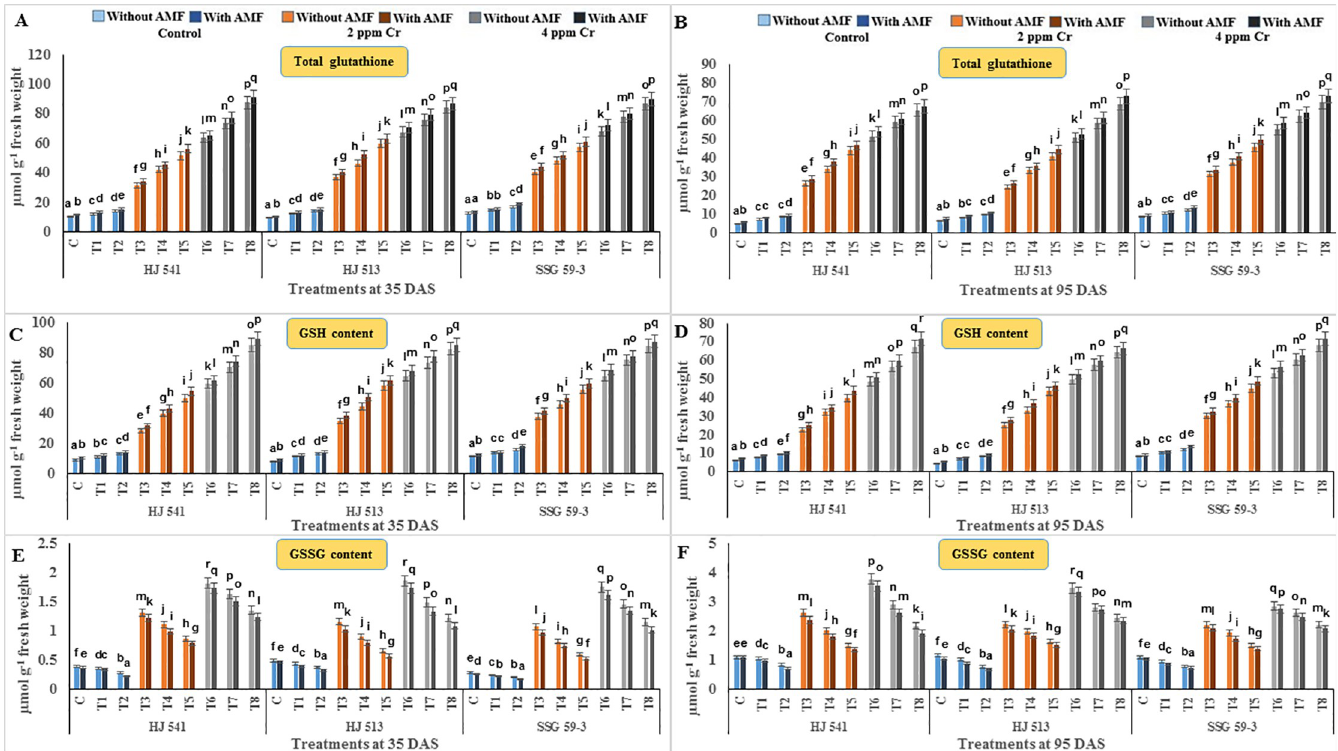
Fig 5. Effects on antioxidant metabolites viz . total glutathione (A and B), GSH (C and D) and GSSG (E and F) in different varieties of sorghum exposed to GB and AMF treatments under Cr toxicity at 35 & 95 DAS, respectively. Data are expressed as means of three replications with ± S.E., N = 3, from three independent experiments. Different letters above the bars in each column indicate significant differences among treatment means based on the least significant difference (LSD) test at P � 0.05.